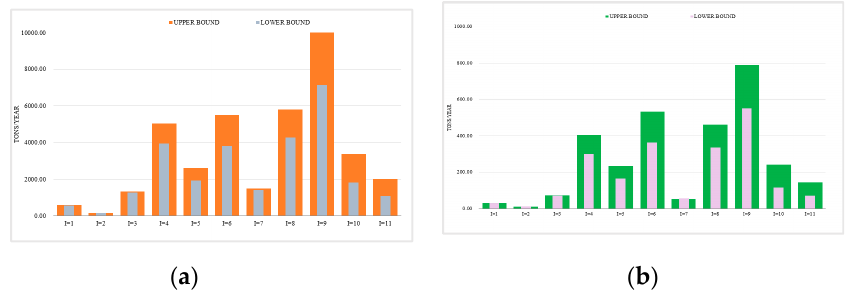
Figure 4. The amounts of COD and ammonia nitrogen flow into the river on different control units in the Yinma River Basin in the first planning period. ( a ) The amount of COD flow into the river in the first planning period; ( b ) The amount of ammonia nitrogen flow into the river in the first planning period.